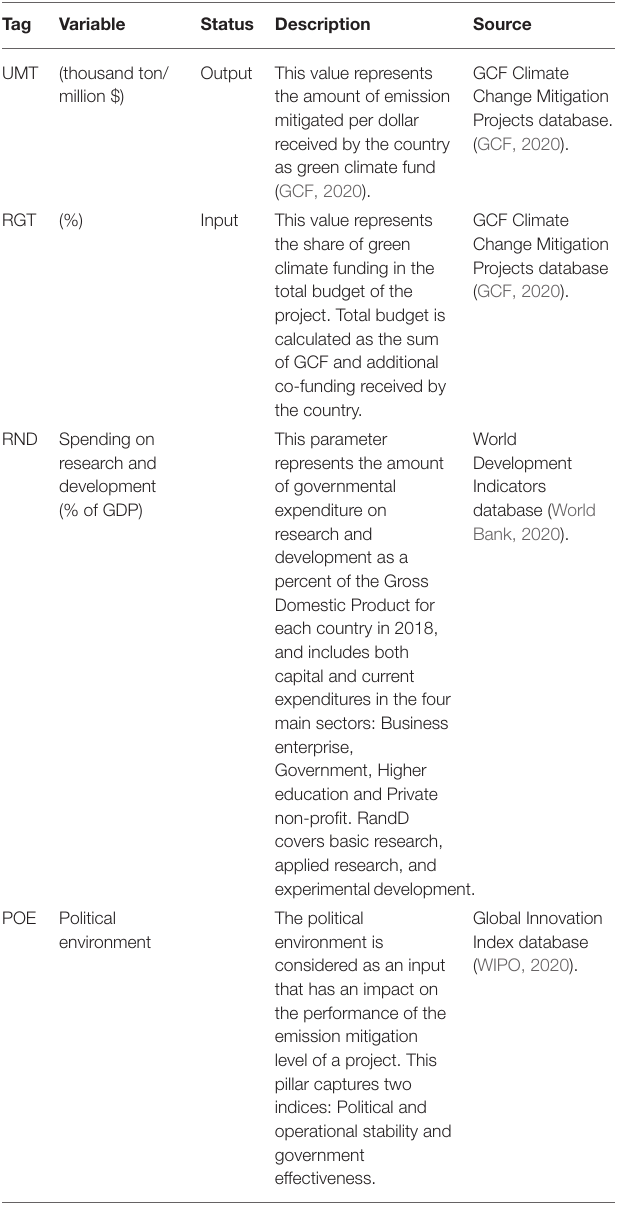
TABLE 1 | Model variables for efficiency analysis. TABLE 2 | Data for selected